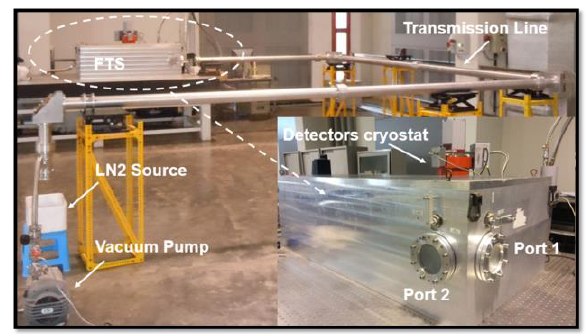
Fig. 9. Transmission line mock-up at ITER India